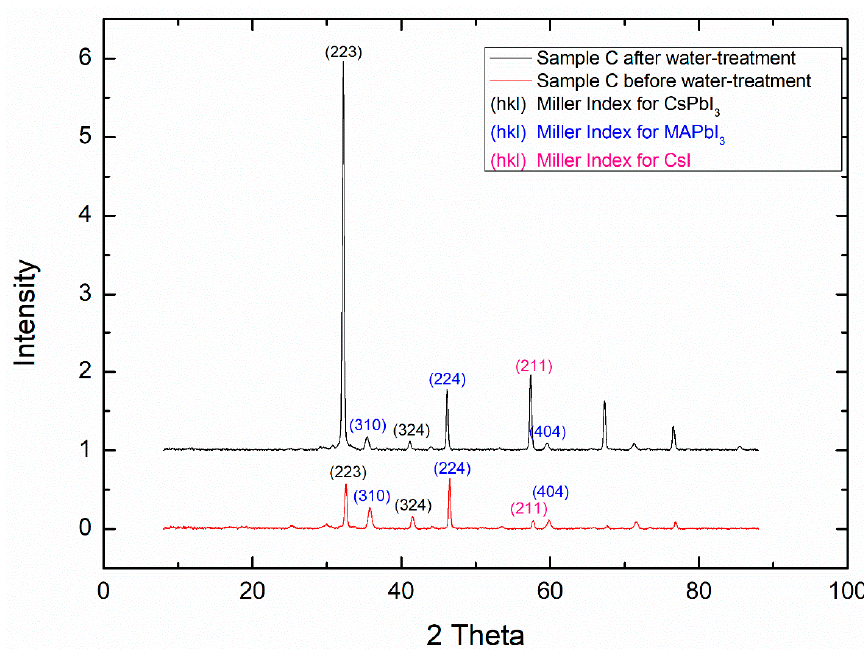
Figure 5. XRD results for sample C (before and after water-treatment).